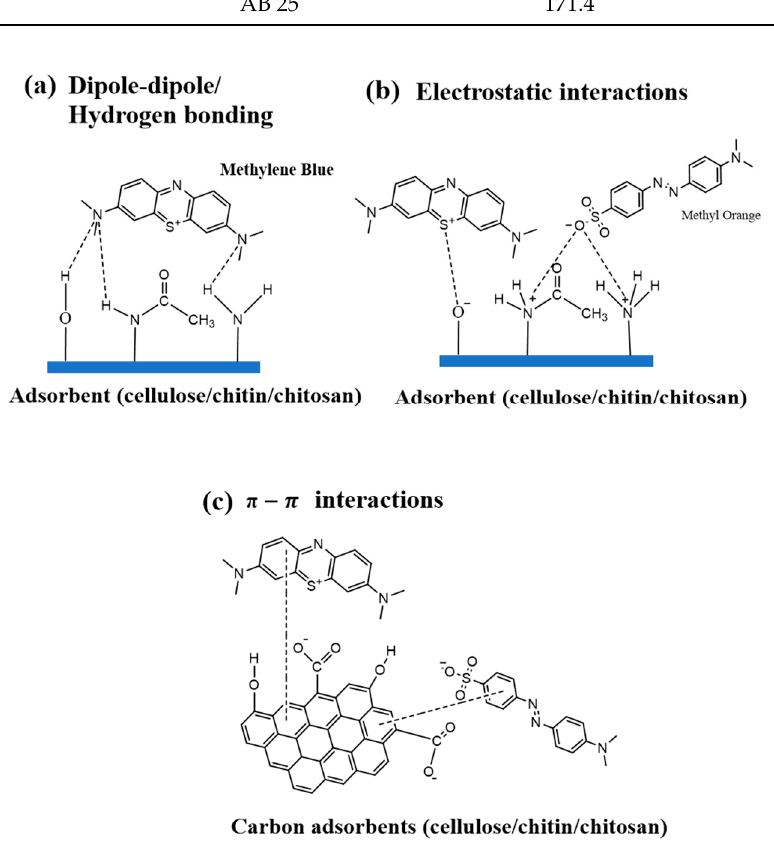
Scheme 1. Schematic representation of the three major adsorption mechanisms of dye molecules (MB and MO) by cellulose, chitin, chitosan and their carbon materials: ( a ) H-bonding/dipole–dipole,